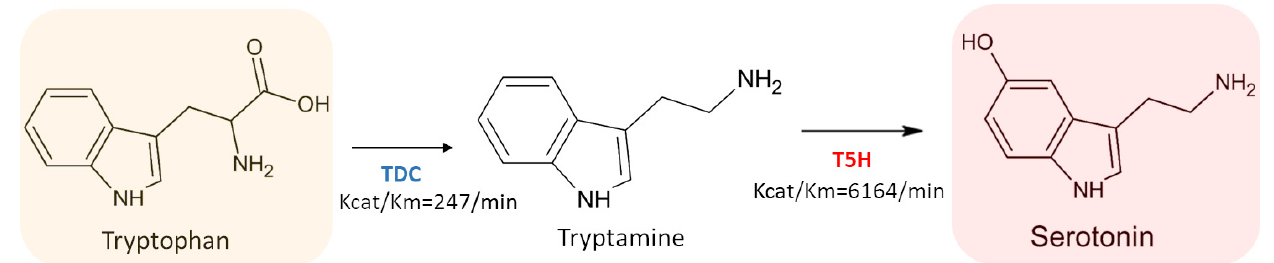
Figure 9. Synthetic capacity of serotonin from tryptophan.